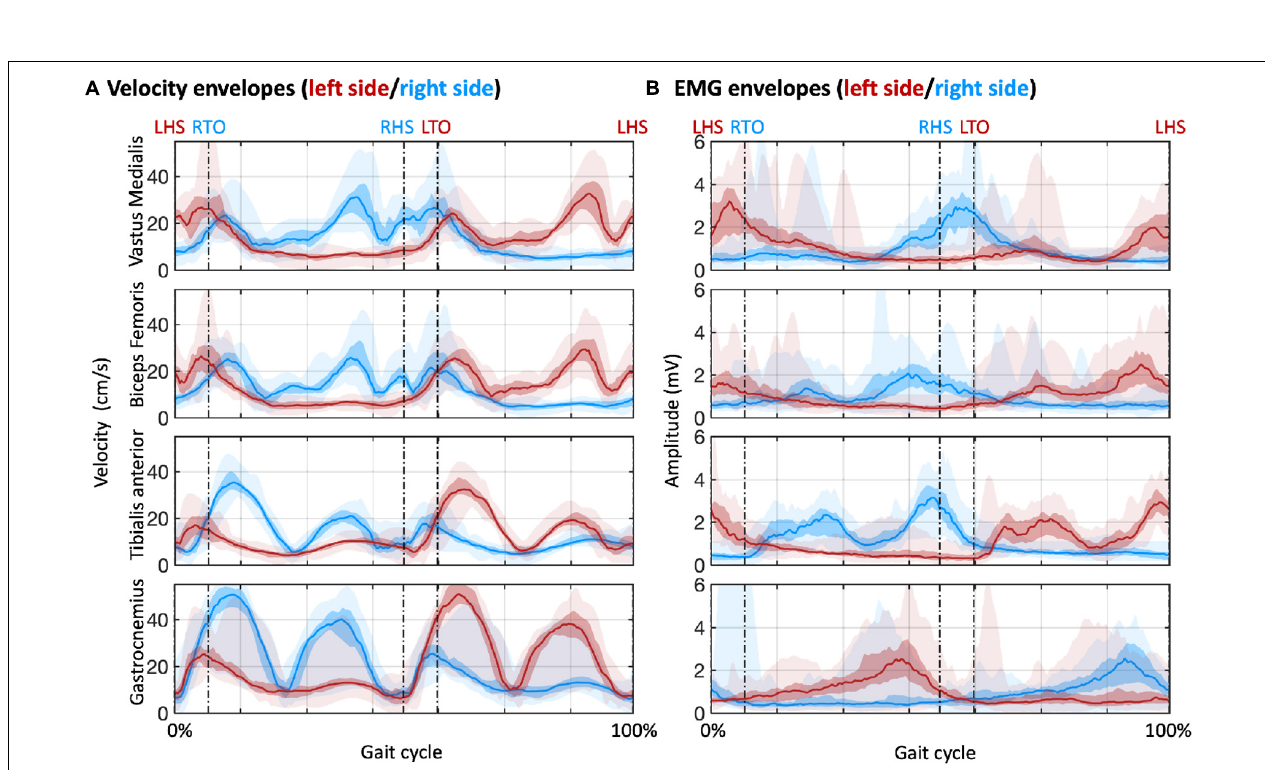
FIGURE 3 | Velocity and EMG envelopes for sensors placed over selected muscles of the lower limbs. The muscles are the vastus medialis, biceps femoris, tibialis anterior, and gastrocnemius. (A) Velocity envelopes in the gait cycles across participants. (B) EMG envelopes in the gait cycles across participants. The lines denote the median across participants; the colored areas denote the intra-quartile range; the areas with semi-transparent color denote the full range (from minimum to maximum) across participants. Red and blue colors are used to indicate results for the muscles in the left and right sides of the body, respectively. LHS, left heel strike; RHS, right heel strike; LTO, left toe off; RTO, right toe